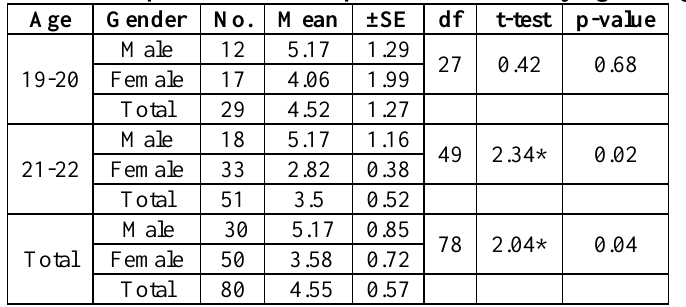
Table 2: Caries experience DS component of DMFS by age and